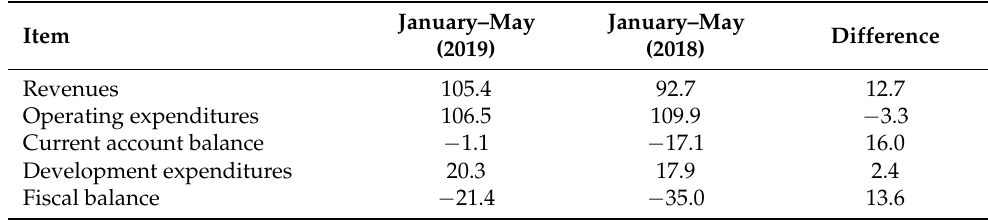
Table 1. The fiscal position of Malaysia (member of UMIE) during the first five months of 2019 and 2018 (MYR billions).